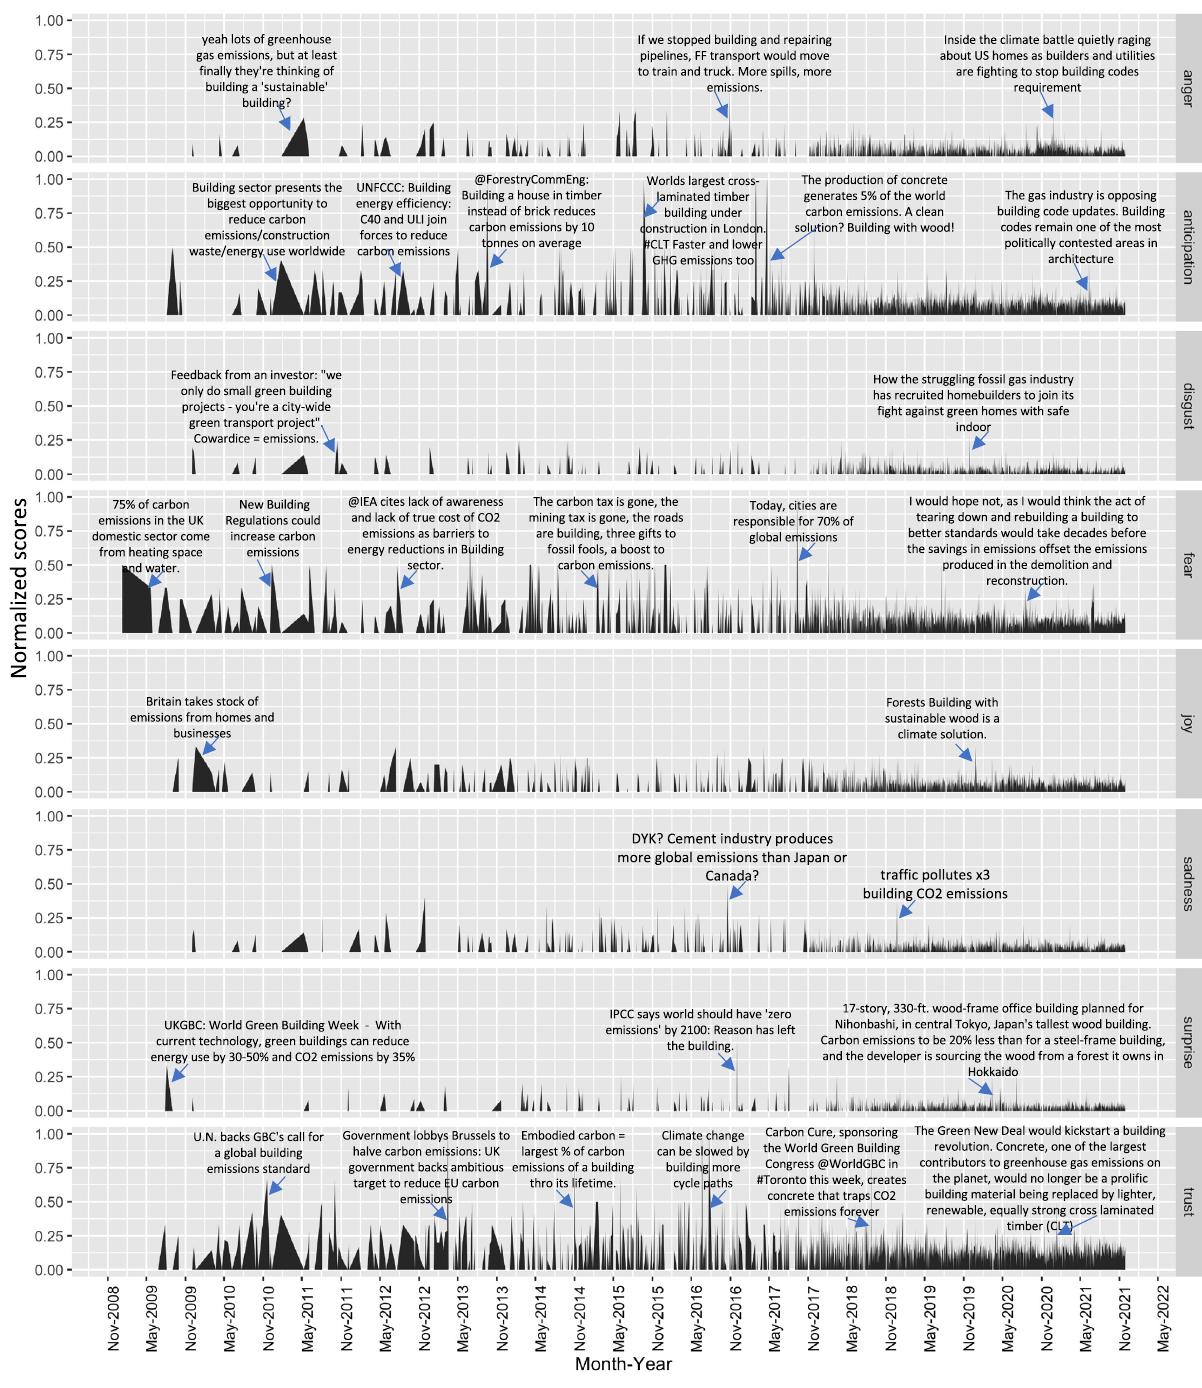
Figure 2. 6-month moving average representation of the estimated emotion distribution in the tweets over the 13 years. Tweets corresponding to the spike in emotion score are shown across the 2009–2021 time scale. The y-axis shows the normalized score on a scale of